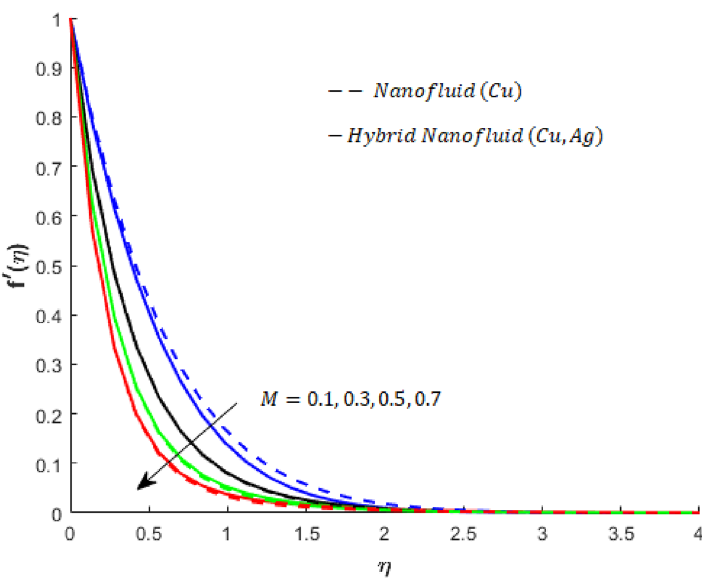
Figure 3. Influence of K ∗ on f ′ when ( Gr ) t 0.2 . Du =